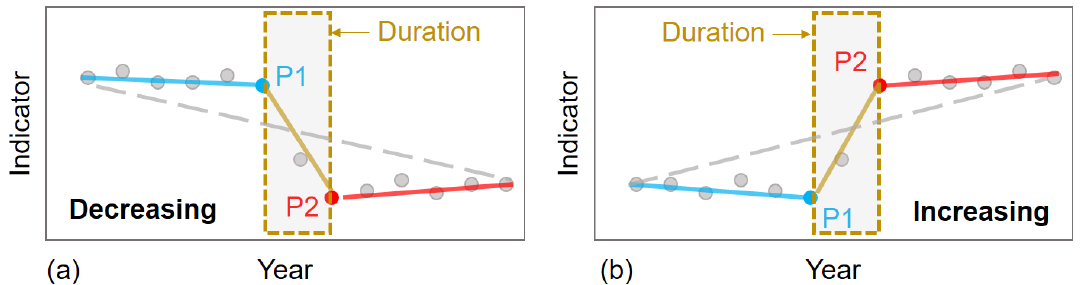
Figure 2. Illustration of the temporal segmentation approach using indicators with decreasing (NDVI) (a) or increasing (MNDWI and SWIR) (b)